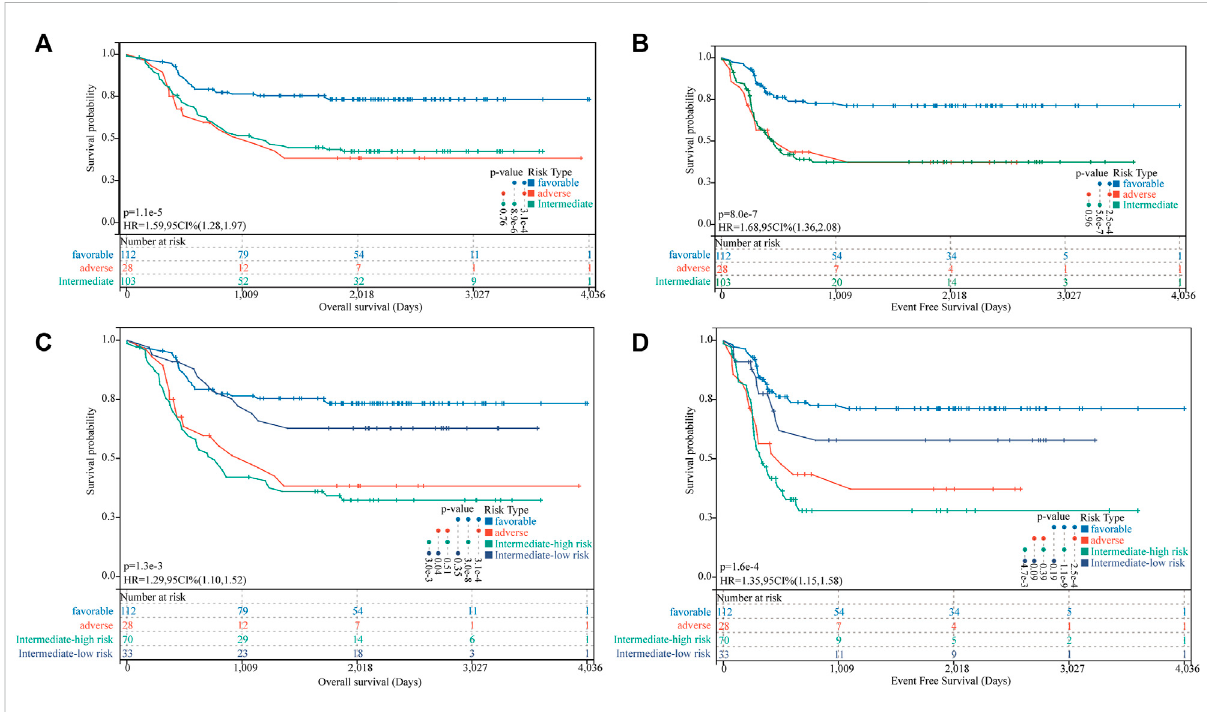
FIGURE 7 Incorporation of the FGL prognostic model in the 2017 ELN risk classi fi cation system. (A,B) Kaplan – Meier survival curves for OS and EFS of P-AML patients in the TARGET-combined cohort strati fi ed according to the 2017 ELN classi fi cation system. (C,D) Patients in the 2017 ELN intermediate-risk subgroup could be well risk-strati fi ed by the FGL risk